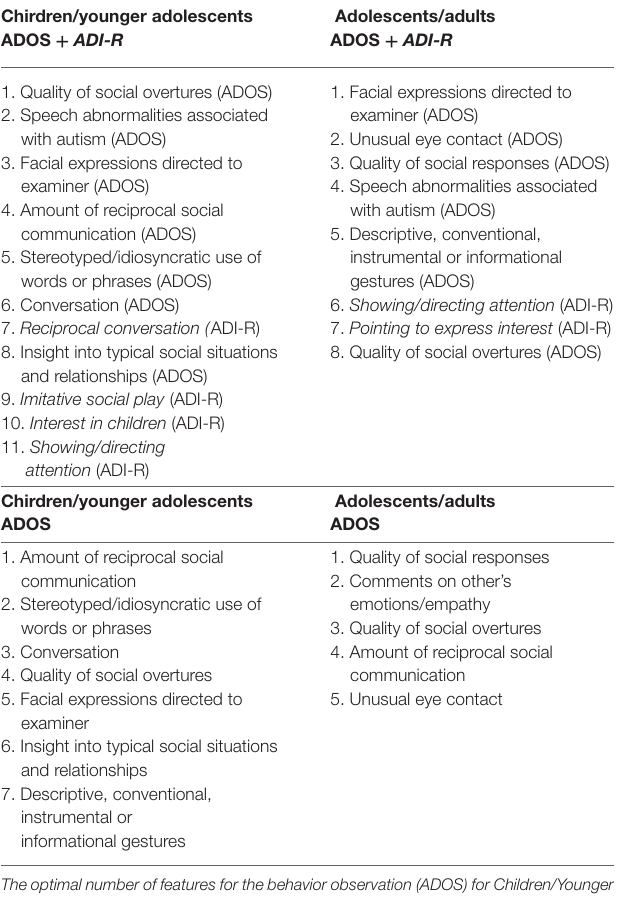
TABLE 3 | The optimal number of features for the combined data (ADOS + ADI-R ) for children/younger adolescents (ADOS module 3 and associated ADI-R data) and adolescents/adults (ADOS module 4 and associated ADI-R data) (upper row left and right). Chirdren/younger adolescents ADOS + ADI-R